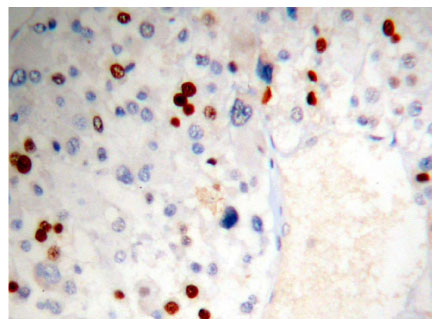
Adrenocortical adenoma Ki-67 (+) SuperisionTM two footworks